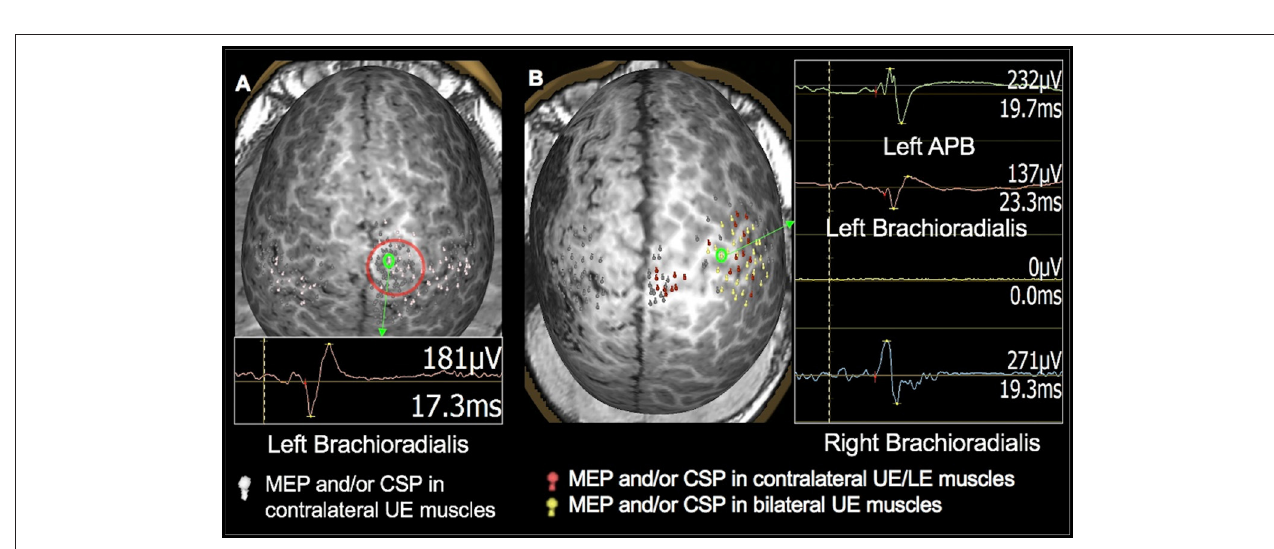
FIGURE 4 | TMS motor mapping demonstrating cortical reorganization in children under 3 years of age. (A) : TMS motor mapping in a 1.7-year-old male with history of refractory seizures involving left-sided tonic flexion with a cortical dysplasia in the medial frontal side of the right frontal lobe on the pre- and post-central gyrus. TMS localized left hand and forearm representation to the precentral gyrus. Additionally, MEPs in the hand and forearm muscles were elicited while stimulating the area of cortical dysplasia. No MEPs were elicited in the left lower extremity even at 100% of stimulator output. The child underwent surgical resection of the lesion. At 9 months follow up, he was seizure-free with intact left-hand function and mild left leg monoparesis. (B) : A 2-year-old male with history of left hemisphere perinatal stroke and right hemiparesis presenting with refractory epilepsy. TMS motor mapping demonstrated no motor representation for right upper extremity in the left hemisphere. Instead, both left and right upper extremities were represented around the precentral gyrus in the right hemisphere. The left hemisphere is on the left side of the image.